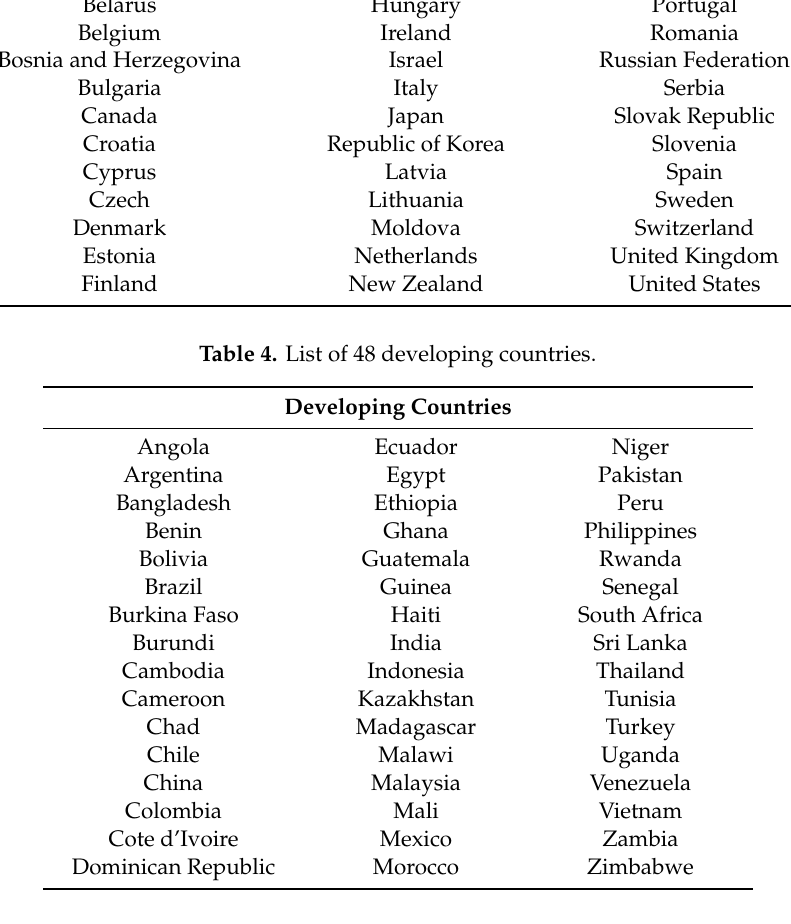
Table 5. Statistical descriptions of the variables for all sample countries (1996–2015). Obs—observations; Min—minimum;